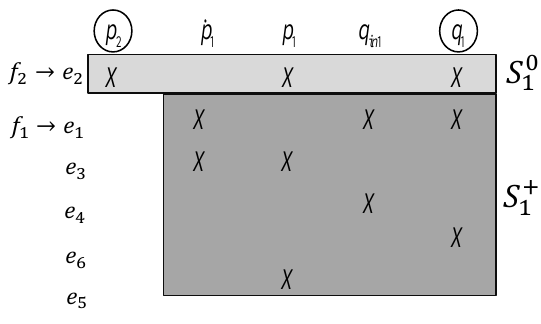
Figure 2. Dulmage–Mendelsohn (DM) decomposition of the first subsystem